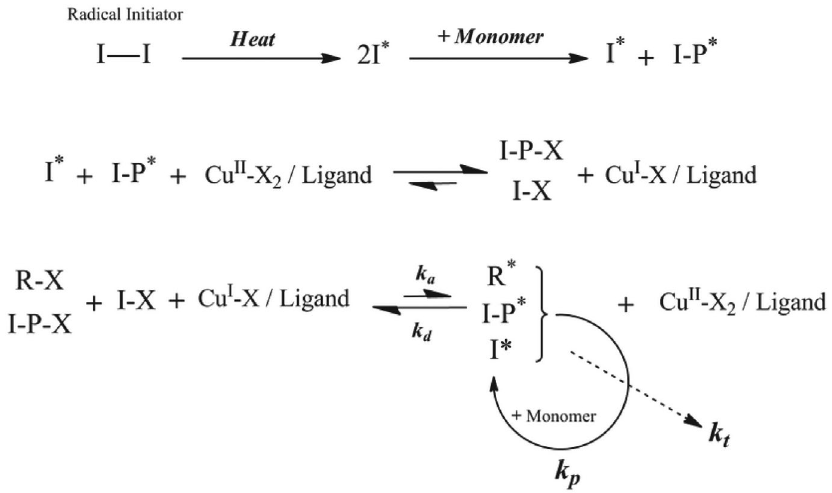
Figure 1. Schematic mechanism for SR&NI